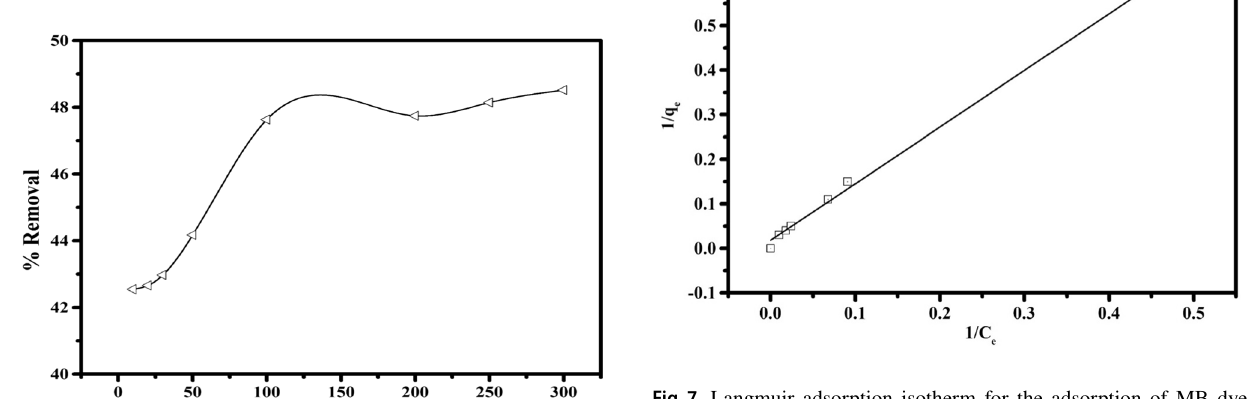
Fig. 7 Langmuir adsorption isotherm for the adsorption of MB dye on PBF